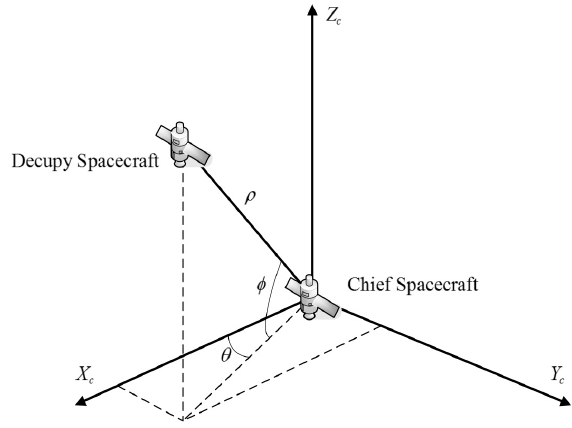
Figure 2. Measurement coordinate